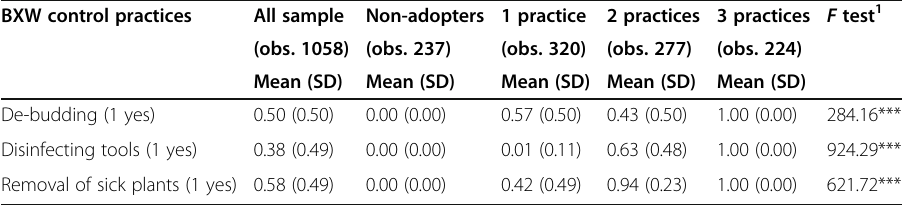
Table 5 Adoption level of recommended practices to control the spread of the BXW as part of Ugandan banana-growing households ’ livelihood strategy